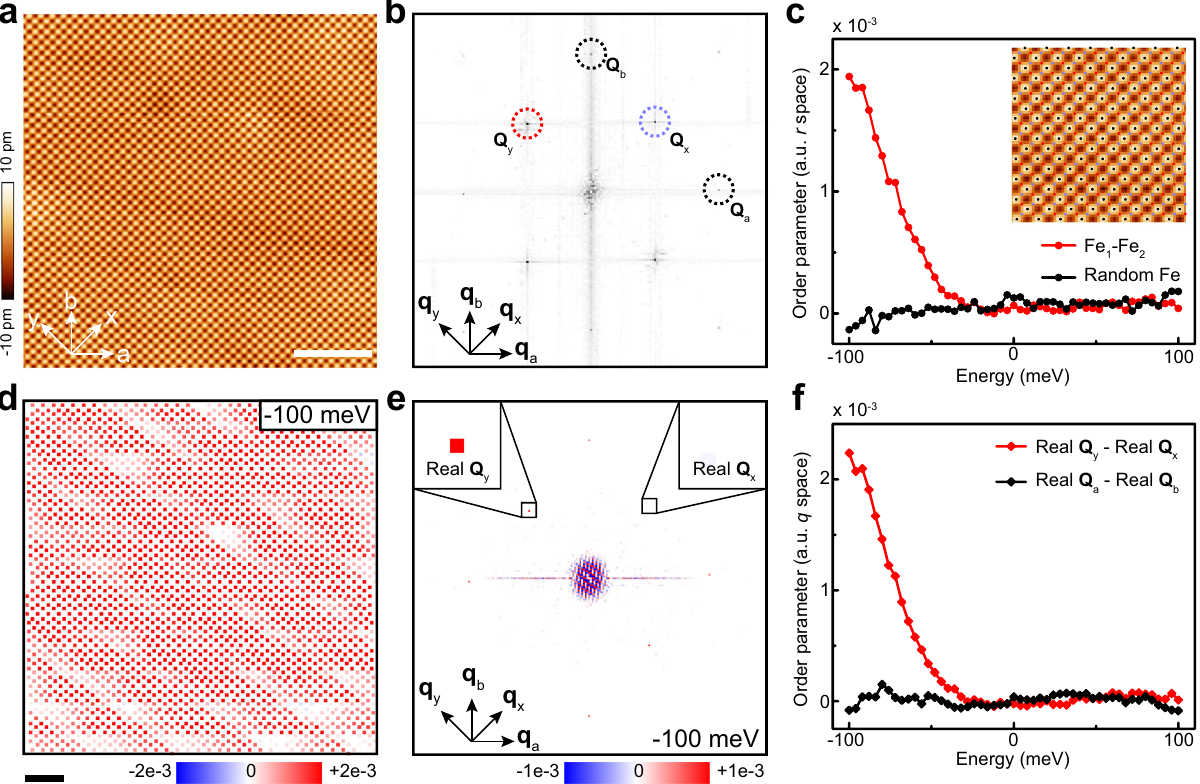
Fig. 2 Observation of a [110] electronic order at liquid nitrogen temperature. a An 18 nm × 18 nm STM image of a clean area under V b = 100 mV and I s = 100 pA (scale bar: 4 nm). b Fourier transform of the drift-corrected topography in a . Bragg peaks of the Se lattice ( Q x , Q y ) and Fe lattice ( Q a , Q b ) are labeled correspondingly. c The red solid dots are the difference between the averaged differential conductance at Fe 1 and Fe 2 sites in selected area. The black solid dots are the difference between the averaged differential conductance at two groups of random Fe sites. Inset shows a part of the drift- corrected topography with precise atomic positions superimposed on it. d The pattern of local [110] electronic order at − 100 meV, with each dot representing the difference between differential conductance at Fe 1 and Fe 2 within one unit cell (scale bar: 2 nm). e Real part of the Fourier transformed conductance map at − 100 meV. Insets show the enlargement of Bragg peaks. The intensities of the Bragg peaks are Re[ g ( Q x , − 100 meV)] = 4.7 × 10 − 5 and Re[ g ( Q y , − 100 meV)] = 2.3 × 10 − 3 , respectively. f The red curve is the difference between real part of Q x and Q y (Re[ g ( q = Q y , E )] − Re[ g ( q = Q x , E )]). The black curve is the difference between real part of Q a and Q b (Re[ g ( q = Q a , E )] − Re[ g ( q = Q b , E named as a collective order parameter ( r space) 8 . An inequivalent here the difference between the differential conductance at Fe 1 and Fe 2 sites represents a checkerboard charge order along the differential conductance between two types of oxygen atoms leads [110] direction of iron lattice. Normally an order parameter does to a nematic order along the Cu – Cu lattice direction. Due to the not evolve with energy, as a traditional order described by the different structure between FeSe and CuO plane of the cuprates,